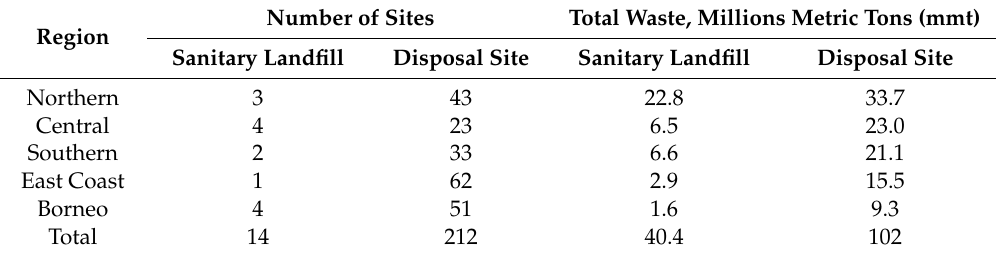
Figure 8. Moving from a linear to circular urban metabolism as a key component towards achieving sustainable cities, which assures the most efficient possible resource use and least generation of waste back into the biosphere [27]. Table 2. The types and number of disposal sites in Malaysia in respect to the amount of waste received [2,26].